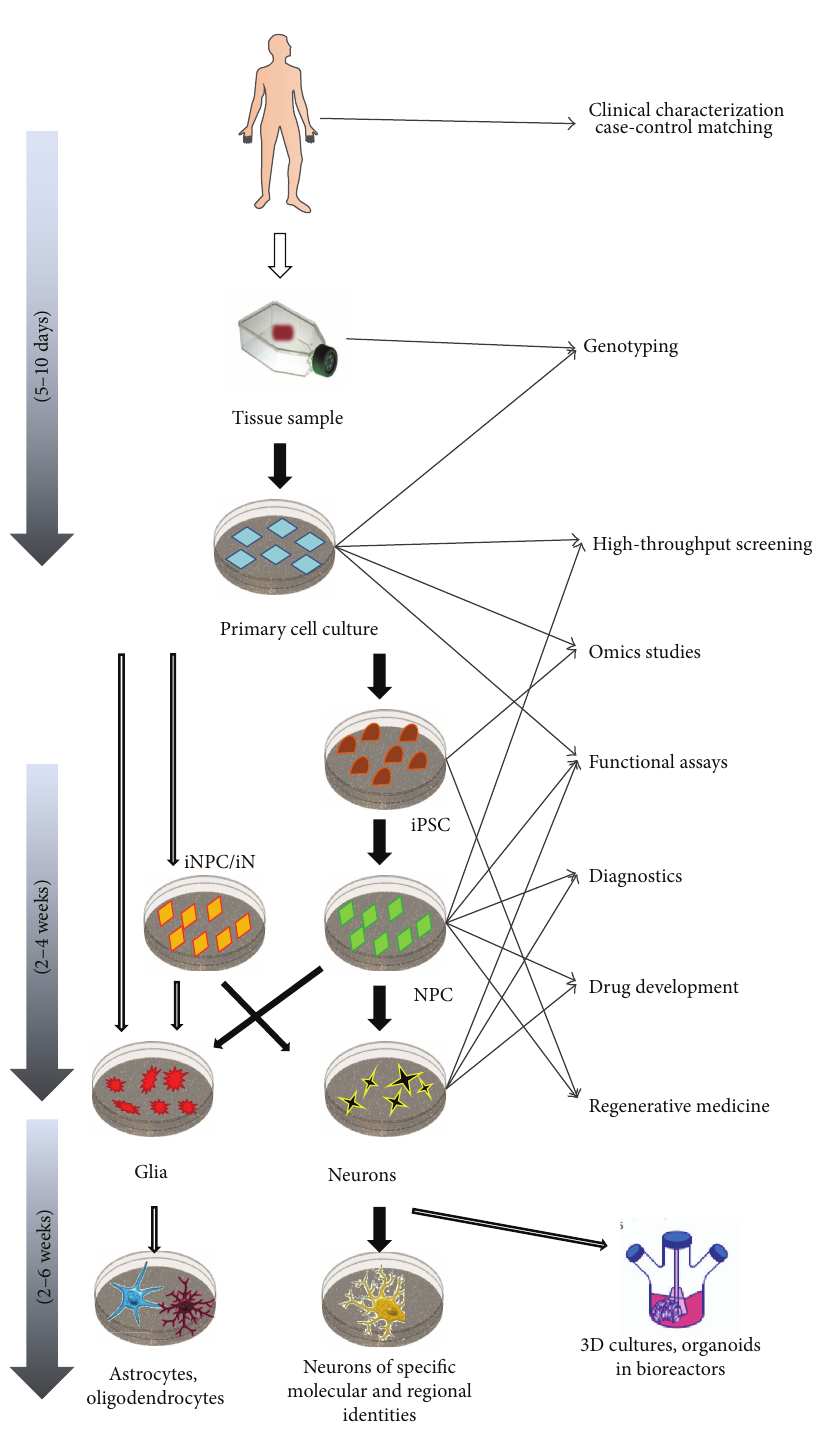
Figure 1: Schematic illustration of induced pluripotent stem cell and neural cell line generation and further clinical and research applications. (iPSC: induced pluripotent stem cell; iNPC: induced neural progenitor cell; iN: induced